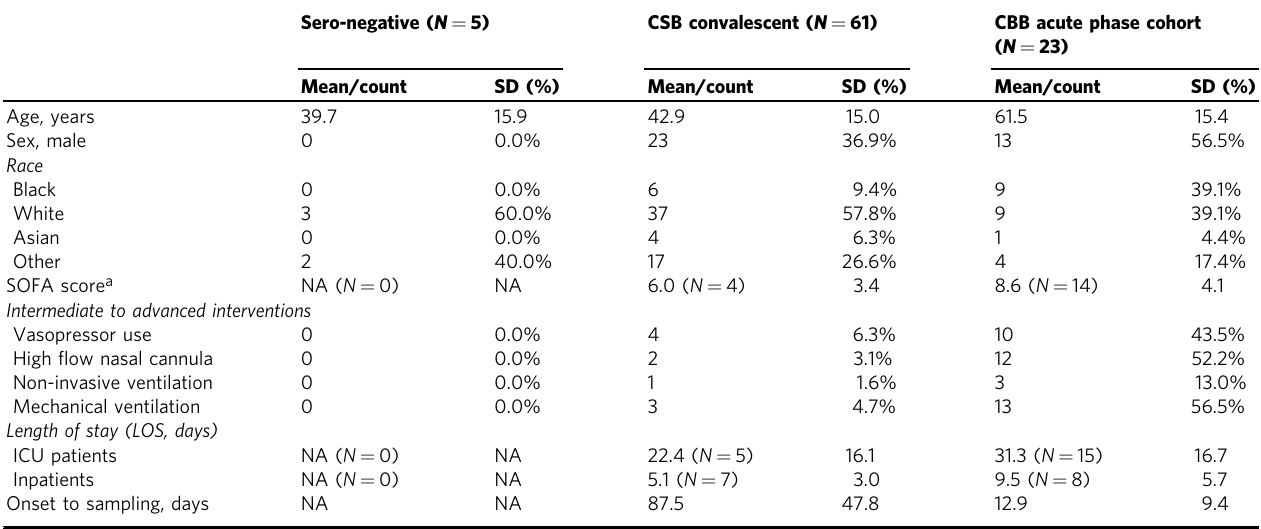
Table 1 Summary of sero-negative, acute, and convalescent-phase of COVID-19 patients from which the plasma ACE2 + EVs and RBD-IgG levels were